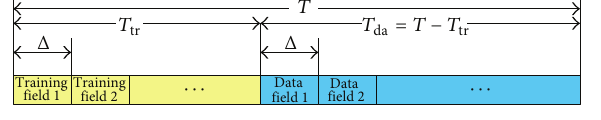
Figure 1: Slot structure.